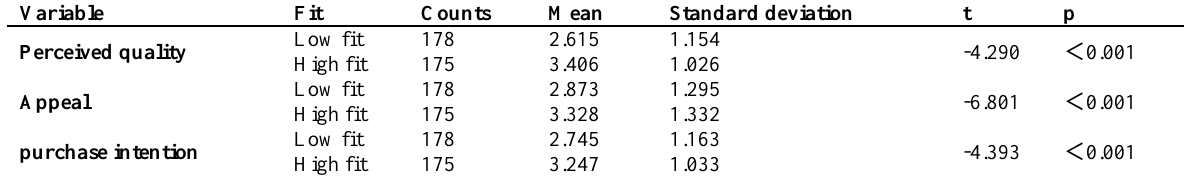
Table 9: Results of significance test of difference of perceived quality, appeal and purchase intention at different level of fit Variable